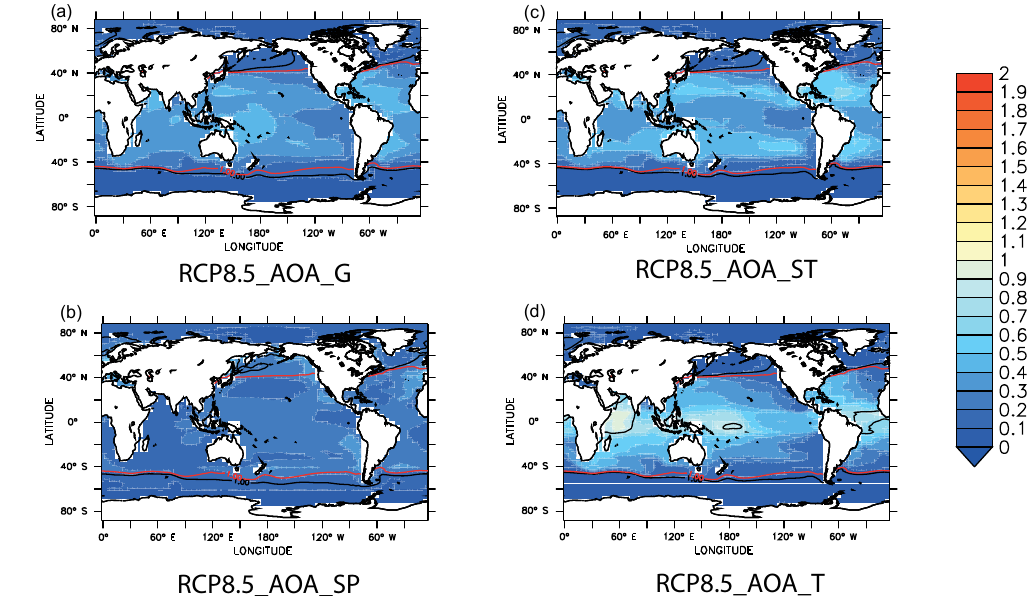
Figure 10. The spatial map of the differences in surface aragonite saturation state in 2090 (mean; 2081–2100), associated with global and regional AOA under RCP8.5, relative to RCP8.5 with no AOA. Contoured on each map are the values of aragonite saturation state of 1 and 3; please see the text for more explanation. The red contours represent RCP8.5 without AOA and the black contours represent RCP8.5 with AOA for each